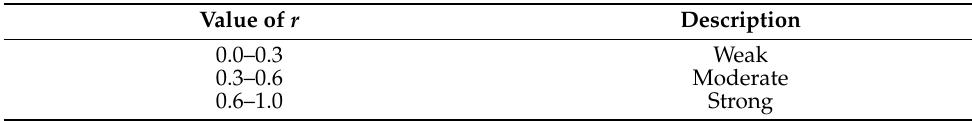
Table 3. Description of correlation related to the value of r .